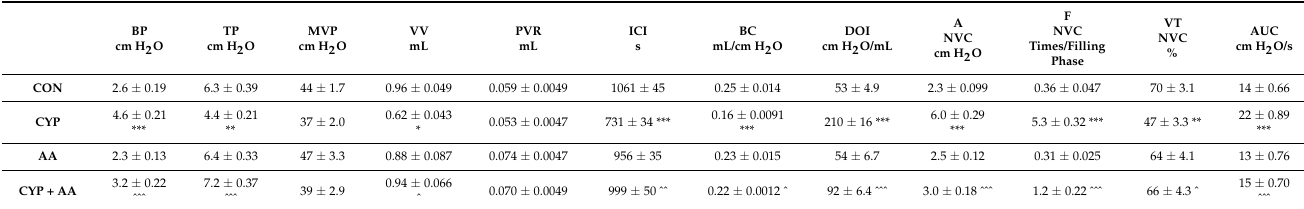
Table 1. The results of pretreatment with asiatic acid (AA) on cyclophosphamide-induced changes in cystometric parameters. BP